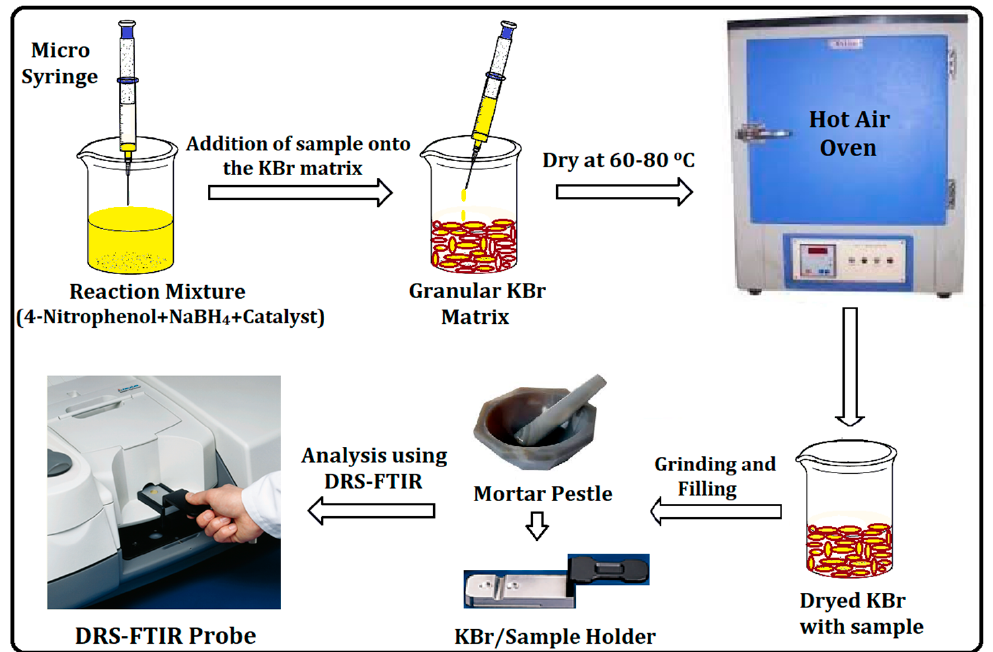
Figure 2. Schematic representation procedure catalysis employing DRS-FTIR.